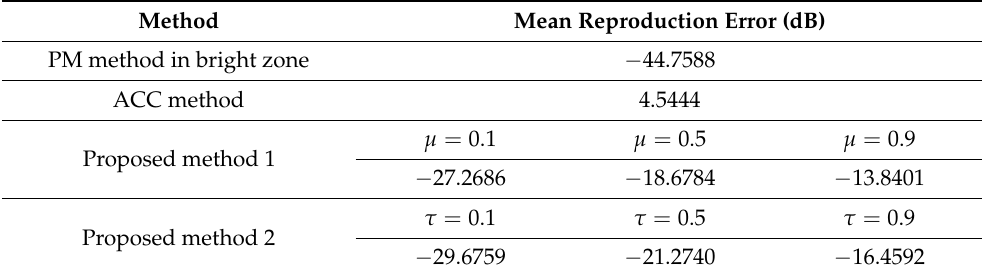
Table 13. Mean normalized spatial average error of different methods relative to frequency for three-dimensional experiment with sparse sampling points.